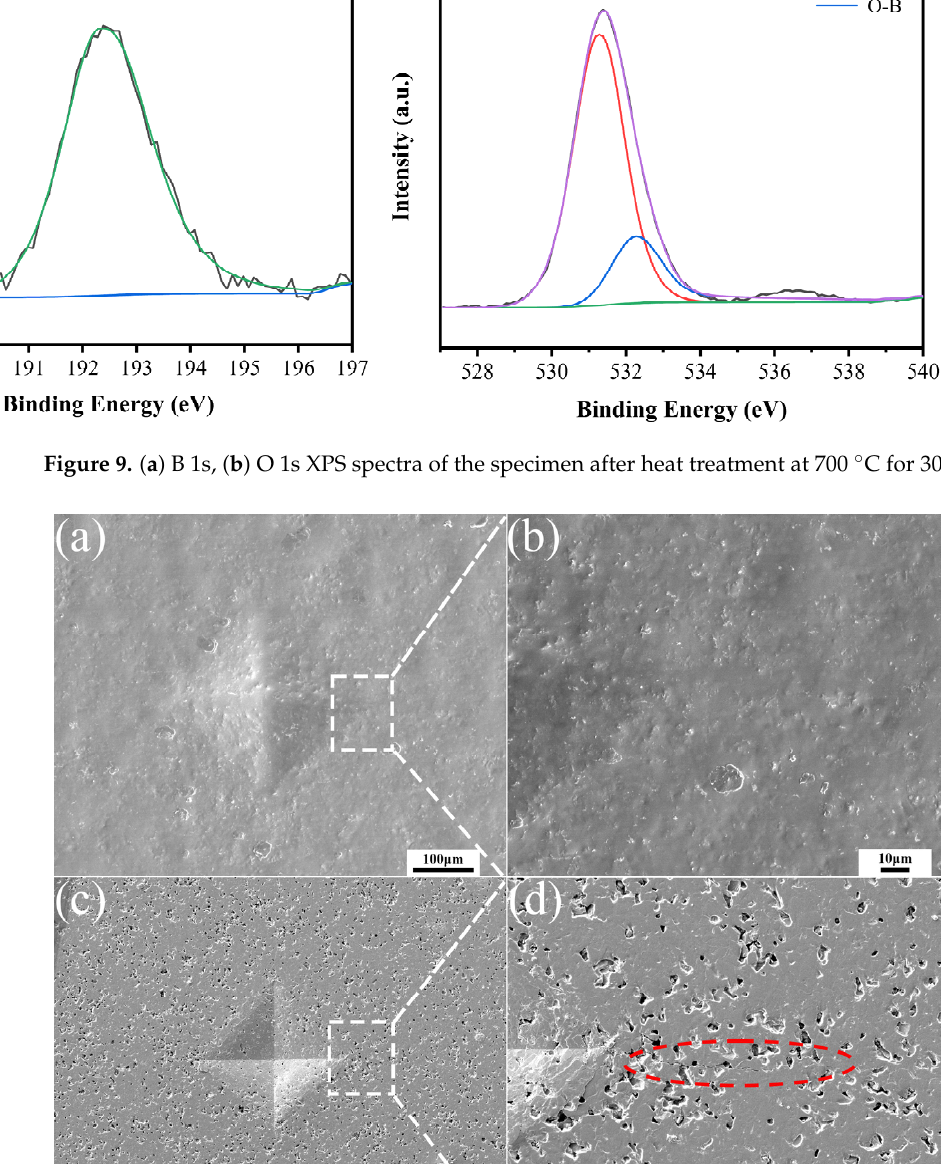
Figure 10. SEM image of Vickers indentation and cracks after heat treatment at 700 °C for 30 min in air, ( a , b ) with healing agent, ( c , d ) without healing agent.